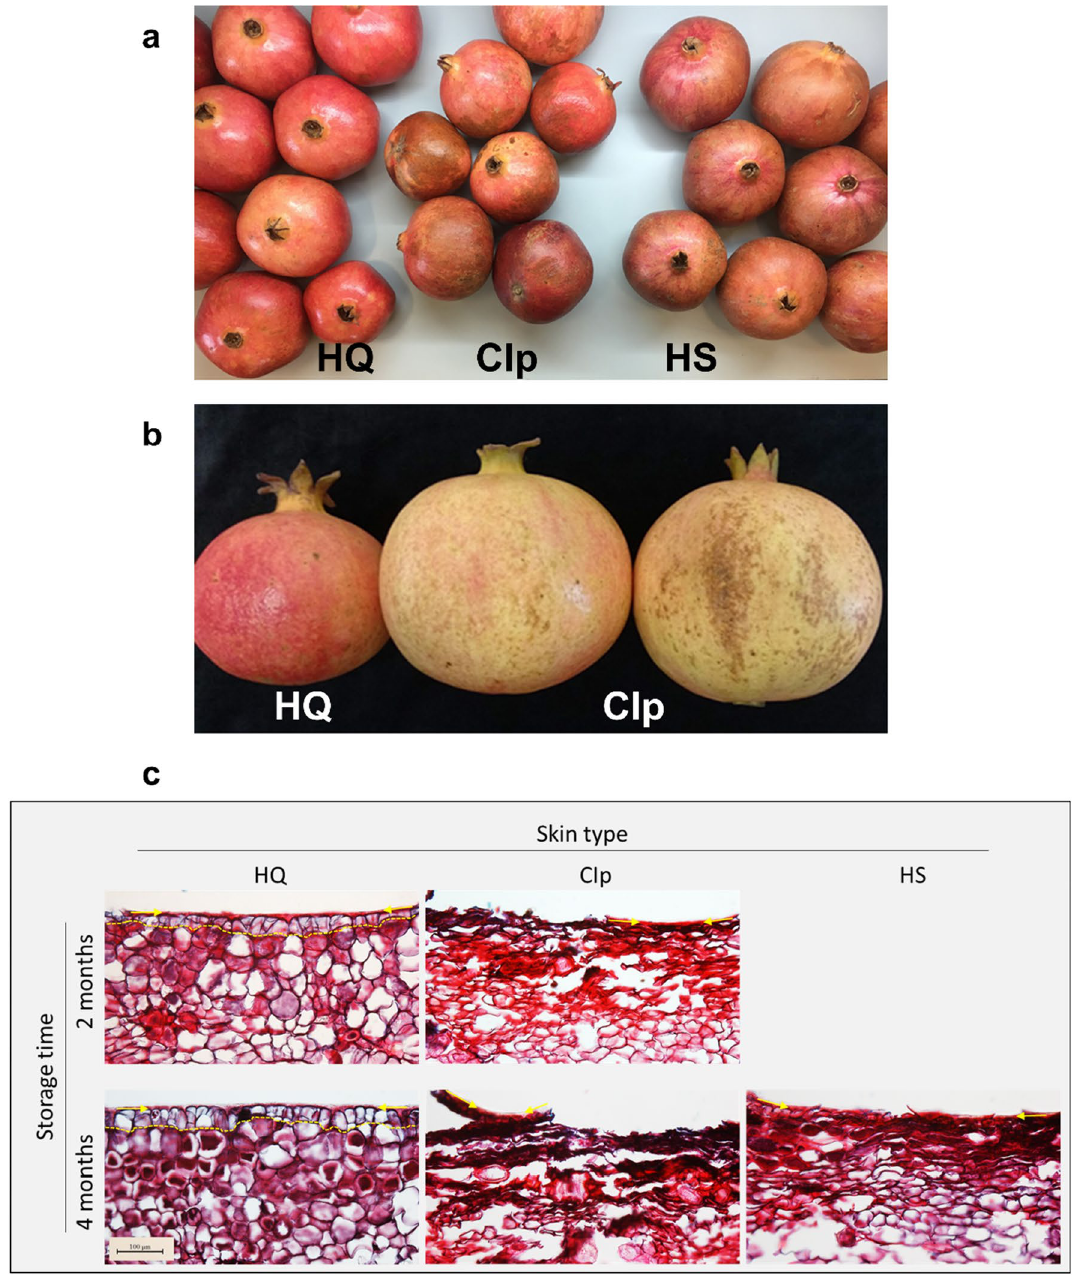
Figure 1. Physiological blemishes on pomegranate skin following 3–4 months of storage at 7 °C in Xtend bags with modified atmosphere. Fruit were collected at maturity ( a ), and at prematuration stage of the skin ( b ). Anatomy of the skin physiological blemishes taken from the mature fruit after 2 or 4 months in storage ( c ). The epidermal cells are underlined with a dashed line. The cuticle layer overlying the epidermal cells is marked with arrows. Each frame demonstrates skin of one representative fruit out of three independent fruit. Bar = 100 µm. HQ smooth, shiny and fully colored skin of high quality, CIp chilling injuries of the skin, appearing as dark brown regions, HS husk scald, appearing as loss of red pigment intensity and development of brownish tint, together with peel well, mixed gently and incubated for 40 min at 37 °C. Analysis was performed with three biological replicates, each with three technical replicates. Reactions were read at 760 nm using the Synergy H1 Hybrid Multi-Mode Microplate Reader (Biotek, Fisher Scientific, USA). TPC values were calculated using a standard curve of 0–0.5 g L −1 gallic acid (#G7384, Sigma Chemicals), and were expressed as g kg −1 gallic acid equivalents (GAE) on a dry weight basis. Profiling of individual HT and AT metabolites was done in the laboratory of Rachel Amir, Migal, Israel 12 . Identification and quantification of punicalagin isomers, gallic acid and ellagic acid were achieved by comparing